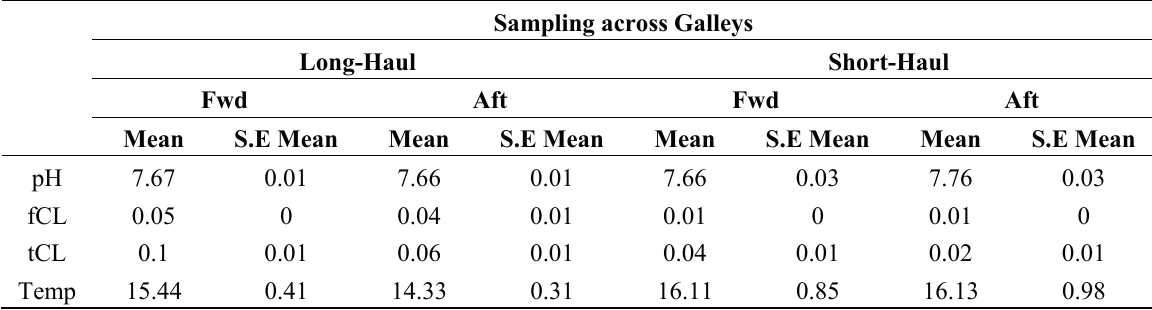
Table 6. Physical and Chemical Analysis for the Galleys across the Long-Haul Aircraft, the Water Source and the Water Service